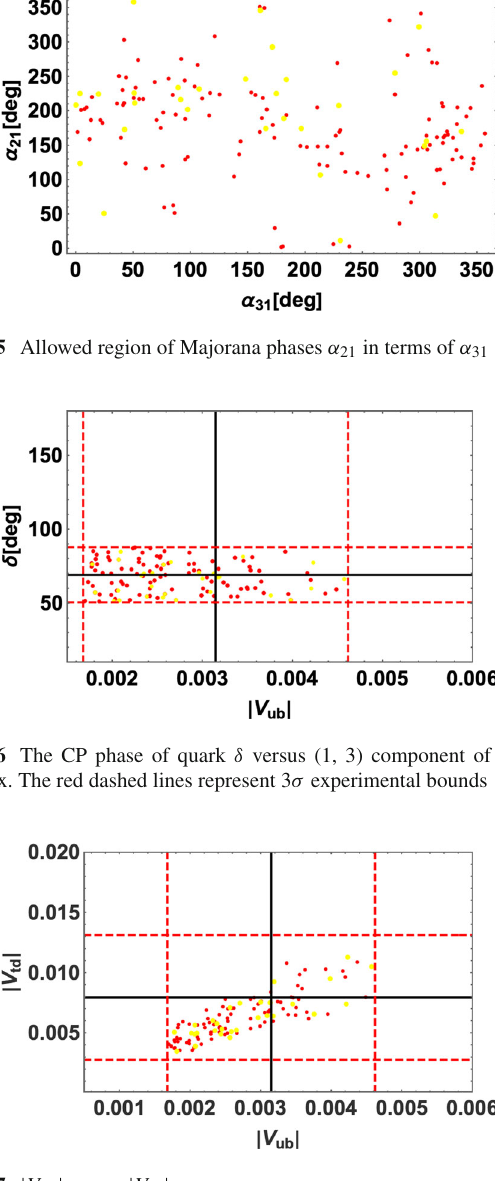
Fig. 7 | V ub | versus | V td